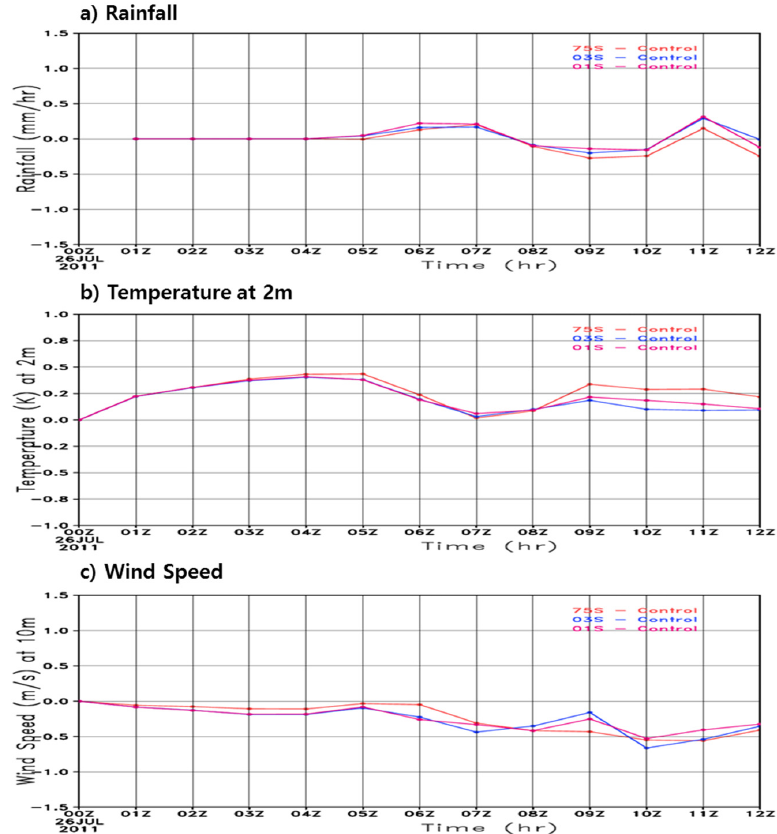
Figure 9. Time series of differences of (a) rainfall, (b) temperature at 2 m, and (c) wind speed at 10 m from 0000UTC 26 July 2011 to 1200UTC 26 July 2011 between 75S, 03S, and 01S and Control.